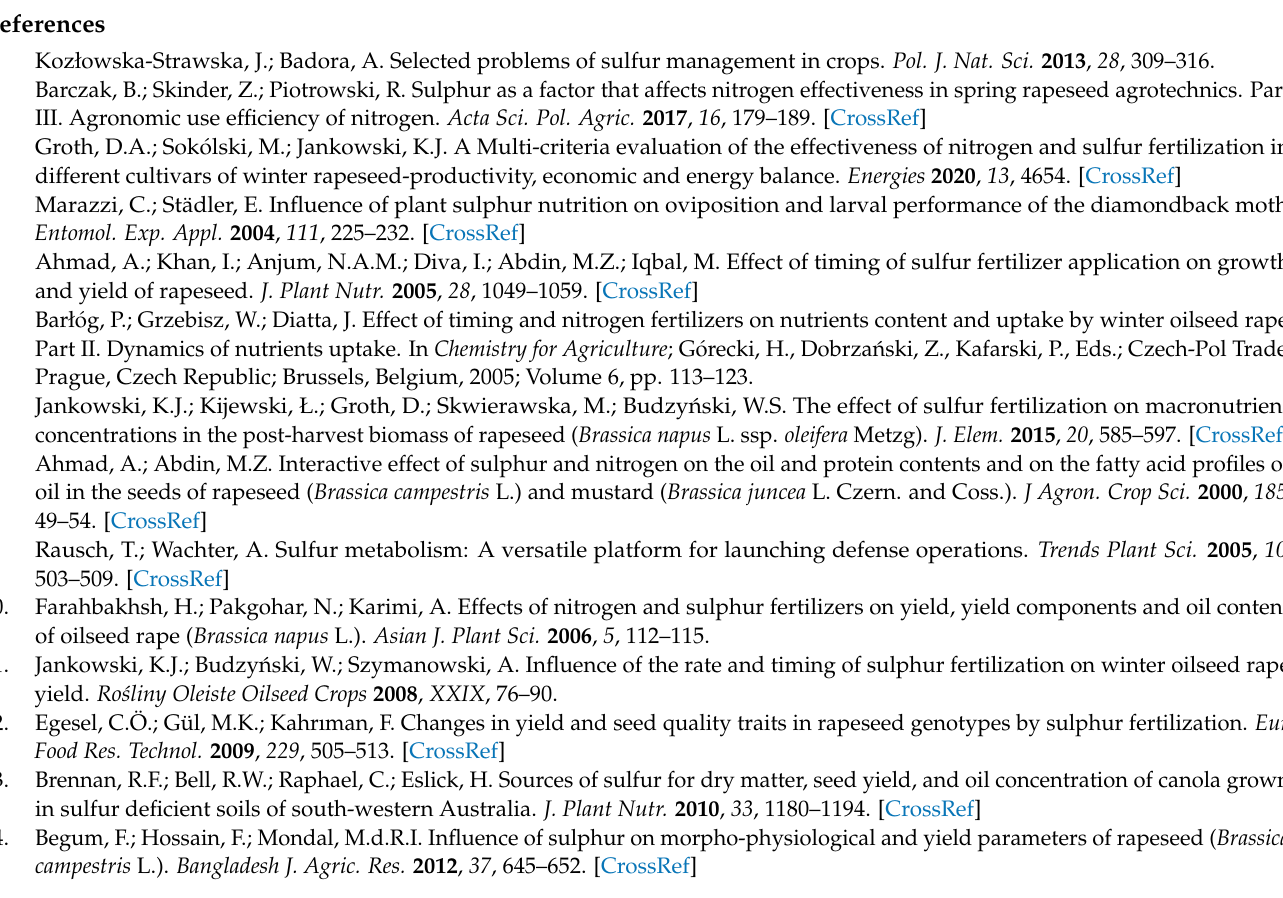
Table S9. Calcium and magnesium harvest index, mean values for interaction variants of sulphur fertilisation ×